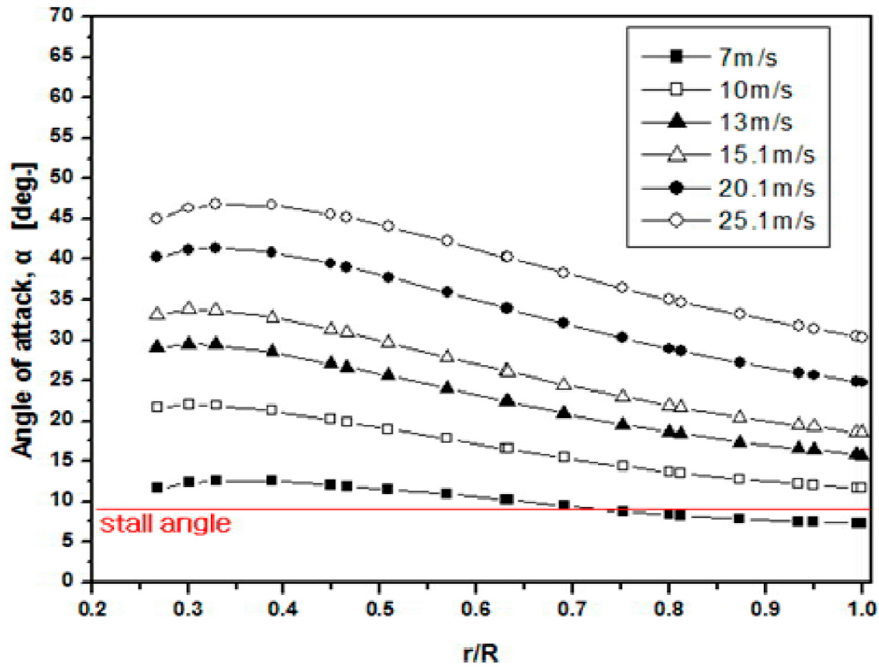
Figure 23. Angle of attack for different wind speeds. [Young-Ho LEE], [Journal of Mechanical Science and Technology 26 (1)]; published by [Springer], [2012]. [27].